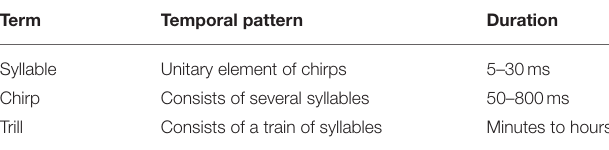
TABLE 1 | Definition of bioacoustic